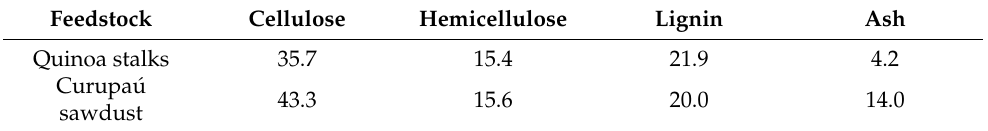
Table 4. Main components of the used lignocellulosic feedstocks, % ( w / w ). Feedstock Cellulose Hemicellulose Lignin Ash Quinoa